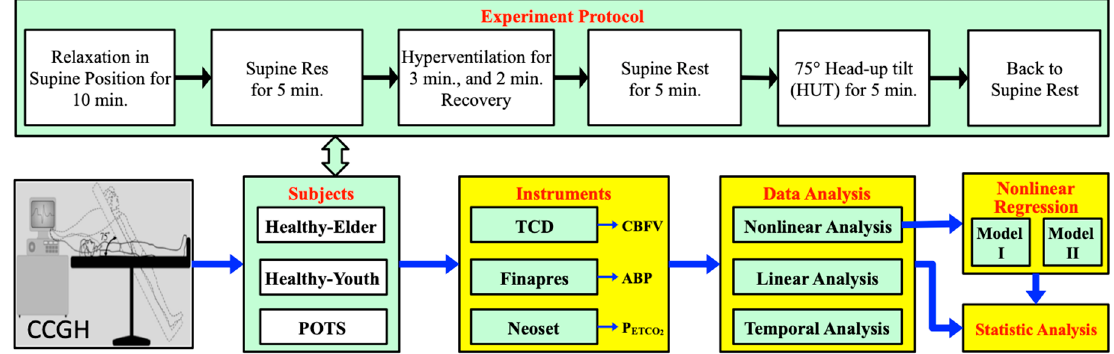
Figure 1. Schematic representation of the experiment protocol, subjects, instruments, and data analysis methods.